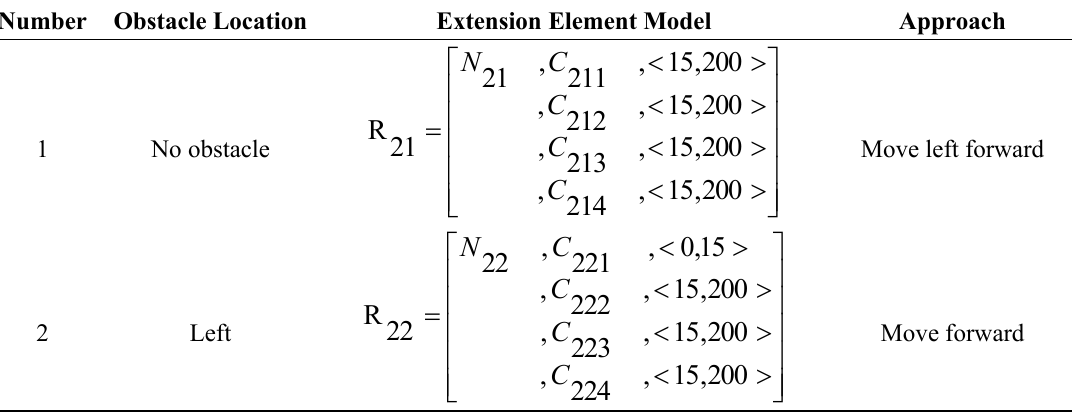
Table 3. Rule table for left forward motion in the extension-element